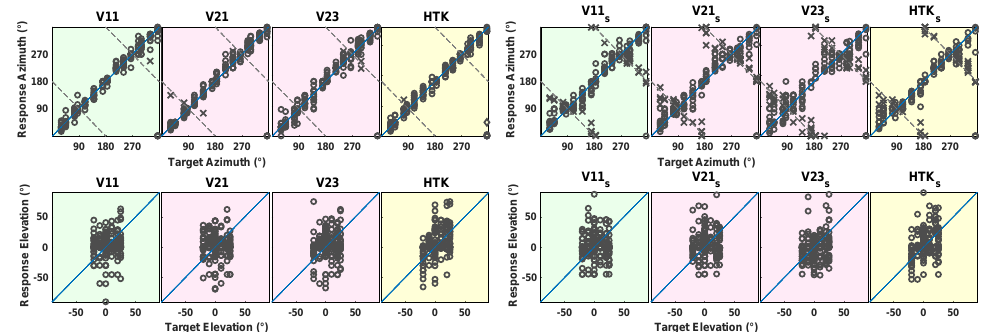
Figure 10. Response azimuth or elevation (ordinate) vs. target azimuth or elevation (abscissa). ( Left ) Results when listening to virtual sources generated with V11, V21, V23 and HTK in TestDynamic. ( Right ) Results when listening to virtual sources generated with V11 s , V21 s , V23 s and HTK s in Test- Static. Responses marked with a × indicate front–back reversals and the response marked with a ♦ indicates an invalid localization. Dashed lines represent possible subject responses in case of a perfect front–back